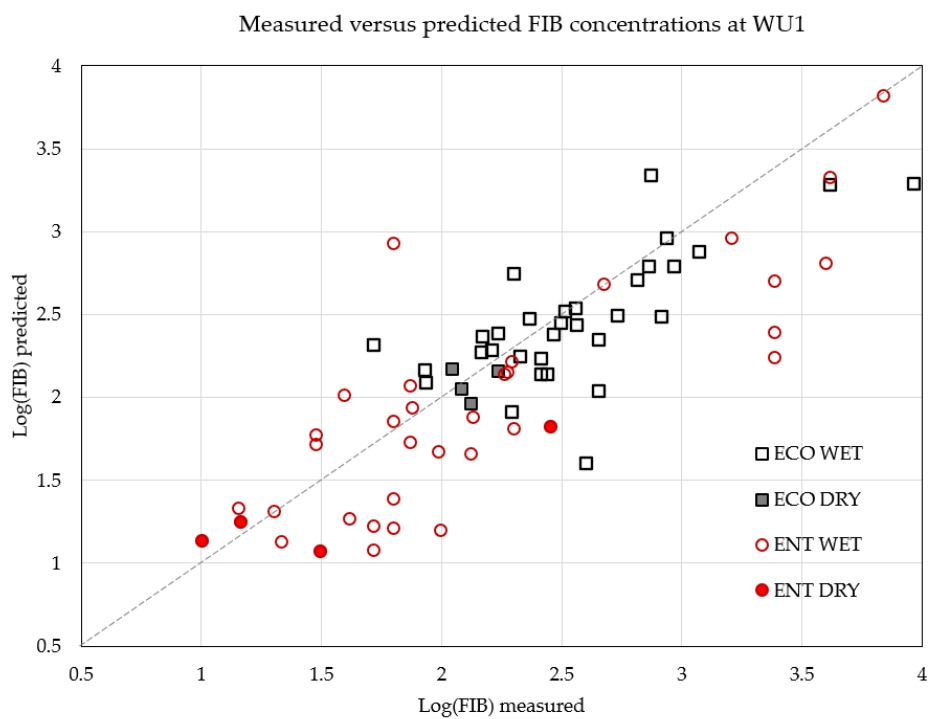
Figure 3. Measured versus predicted values of FIB after the confluence of Sauquoit Creek and the Mohawk River in Utica, NY.